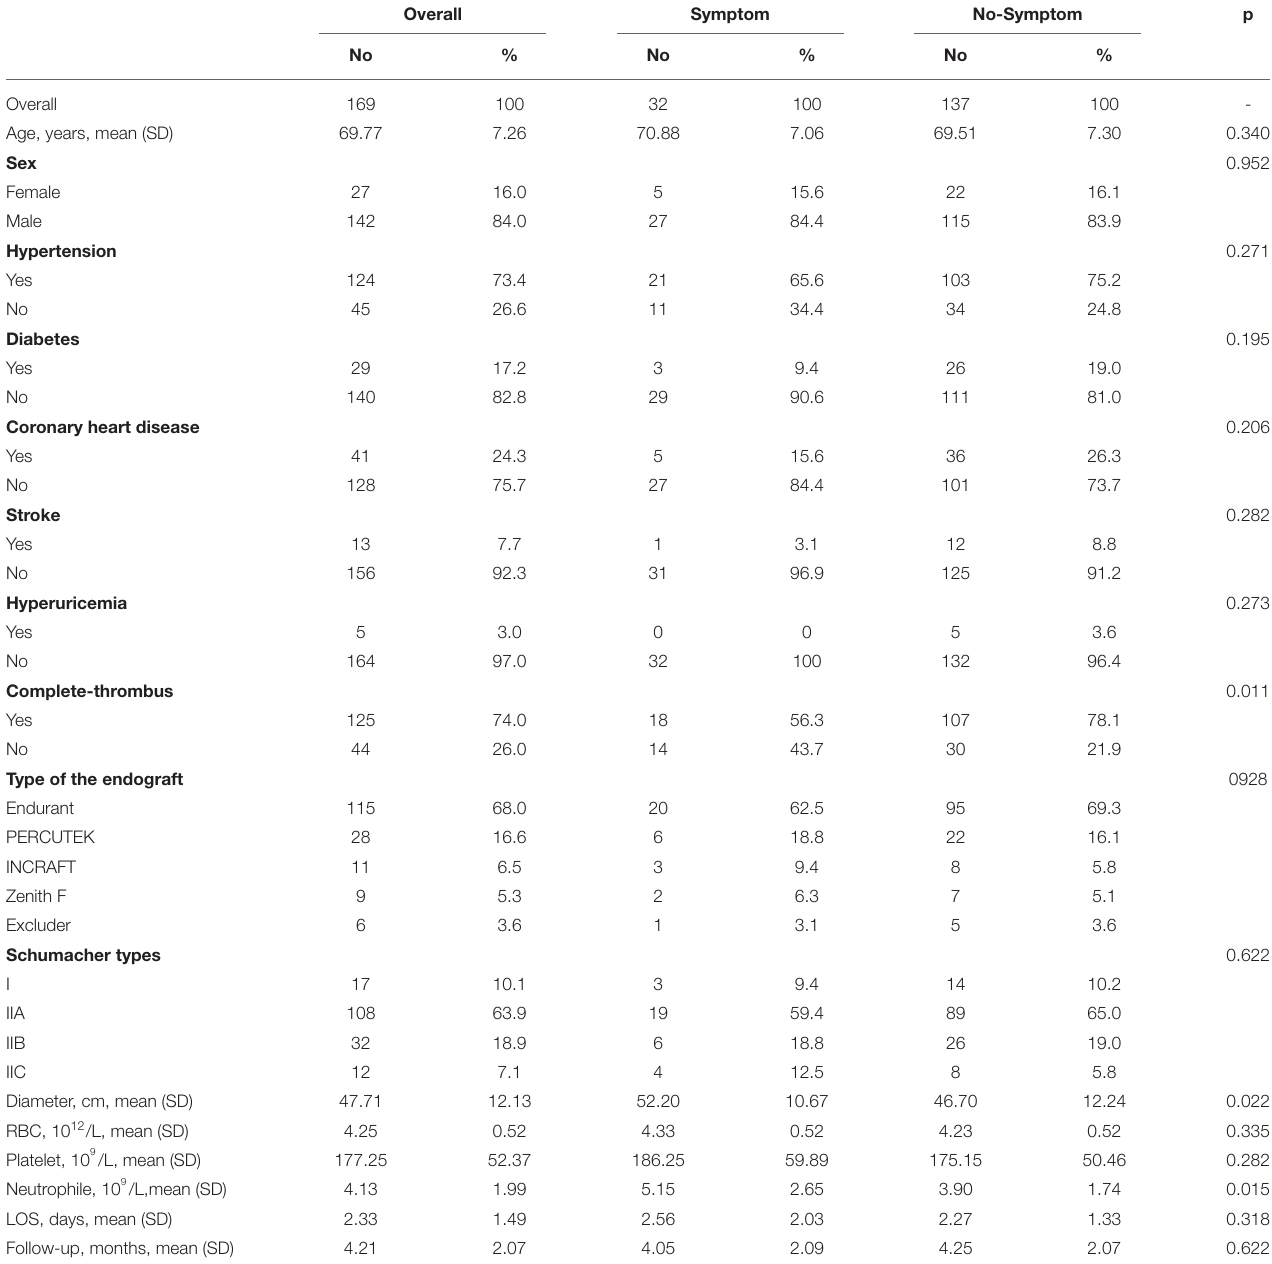
TABLE 1 | Patient characteristics grouped by the presence or absence of symptom.